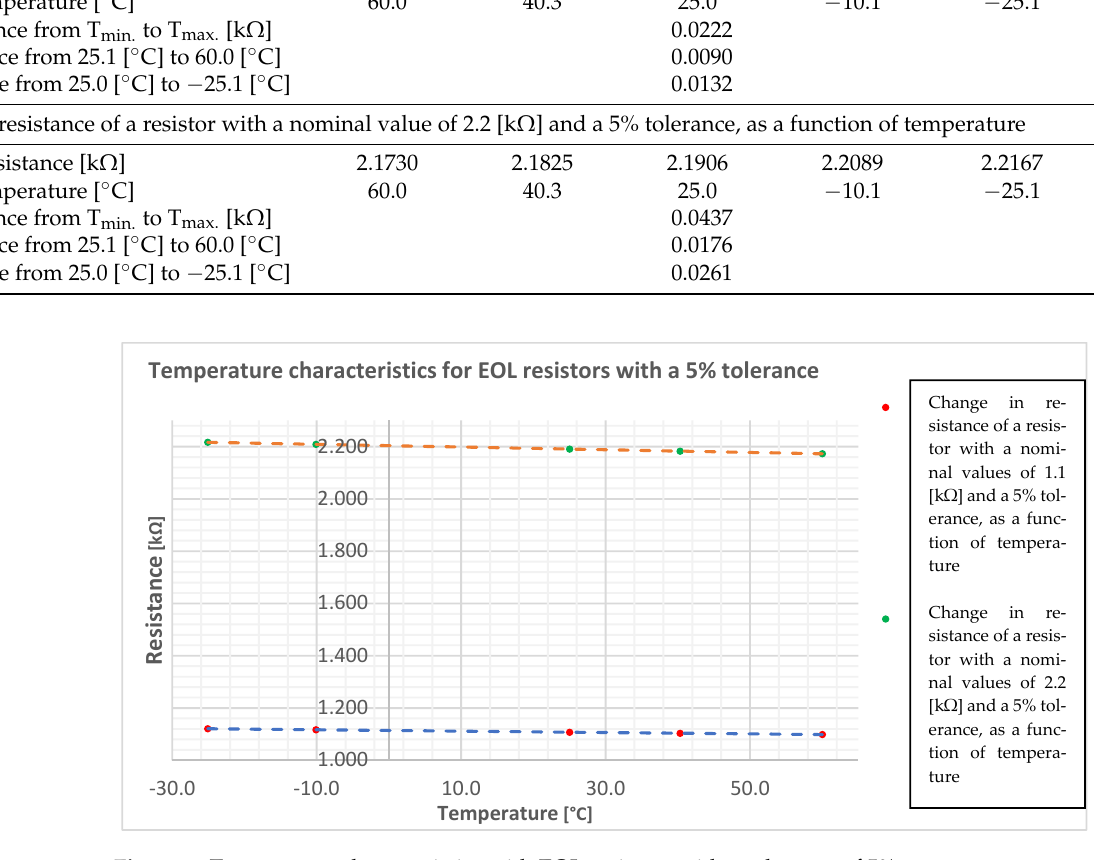
Figure 6. Temperature characteristics with EOL resistors with a tolerance of 5%.